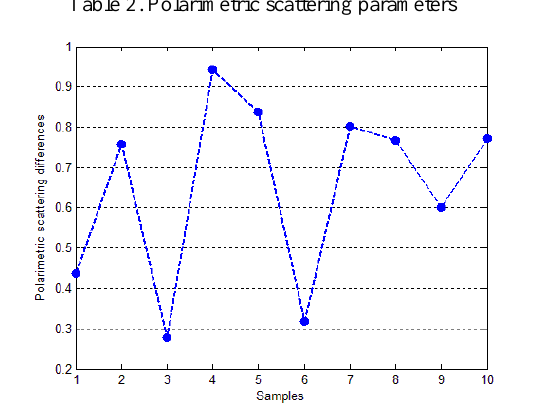
Table 2. Polarimetric scattering parameters